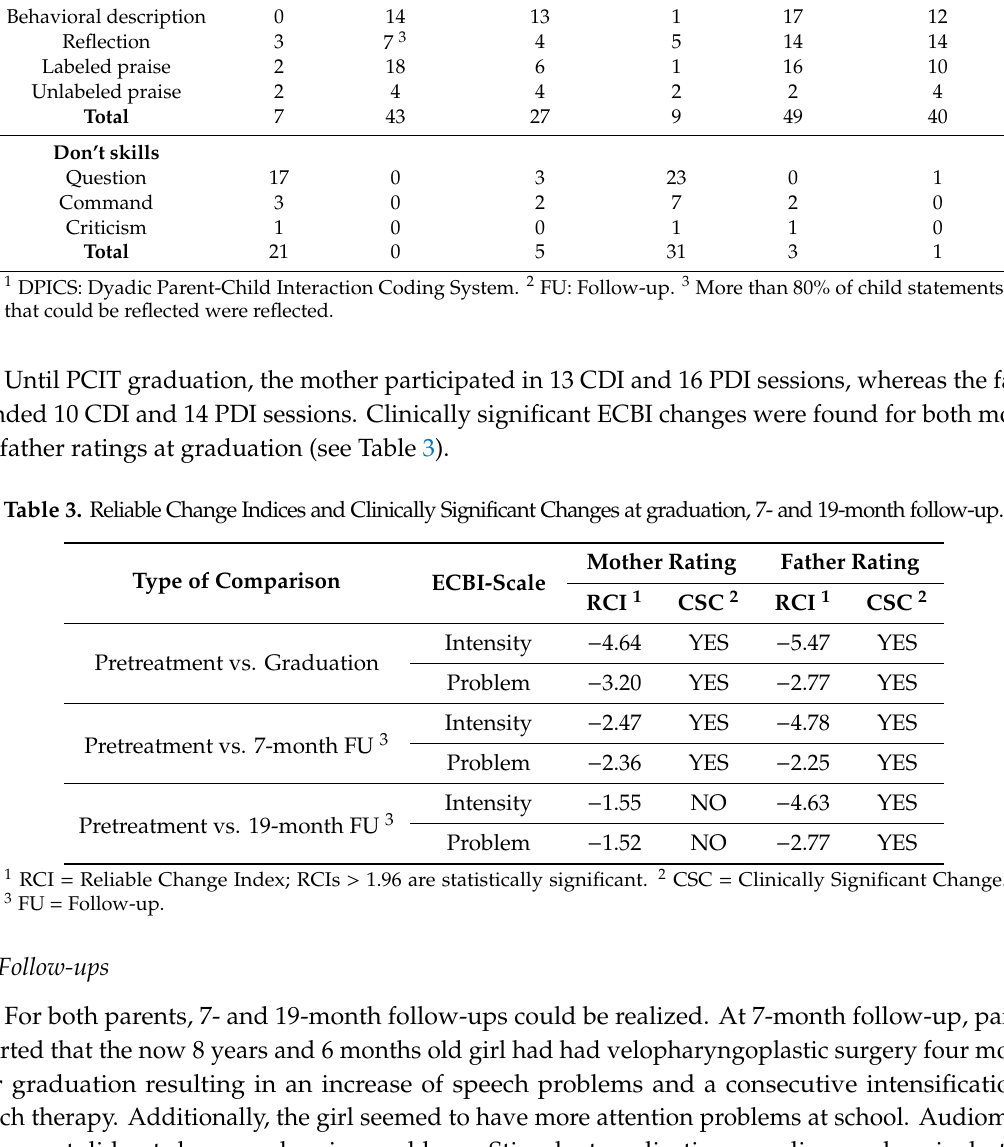
Table 2. Parents’ Child-Directed Interaction (CDI) skills during Child Led Play at baseline, graduation, and 19-month follow-up. Mother DPICS 1